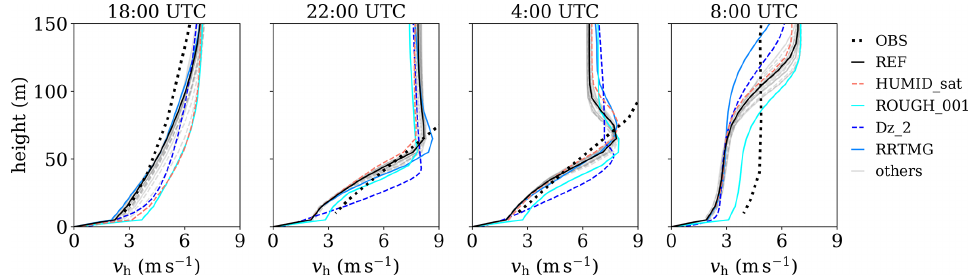
Figure 10. Vertical profiles of mean horizontal wind speed as measured at Cabauw (OBS) and for all cases listed in Table 5. Only case REF and some relevant cases are highlighted; all others are shown in